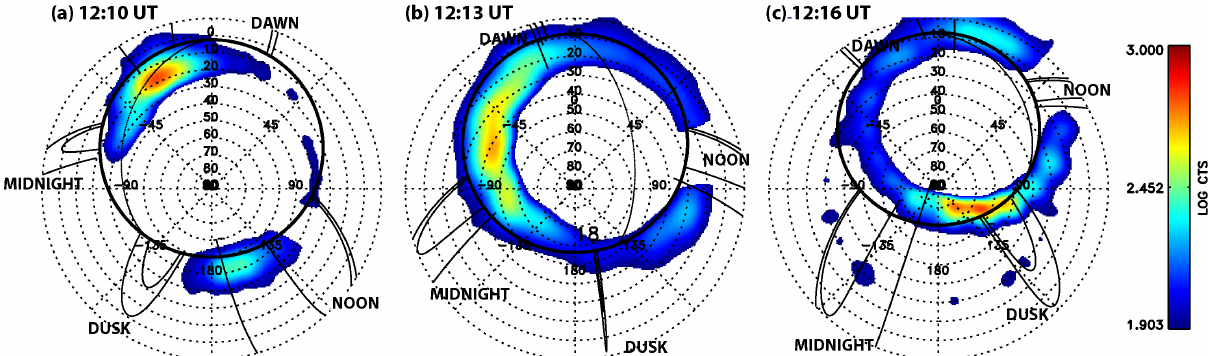
Fig. 13. A sequence of plots showing ENA emissions recorded by NUADU on 14 September 2004 while traversing the south polar cap. The SM co-ordinate system utilised has its Z-axis parallel to the dipole axis of the Earth; the XZ plane contains the Earth-Sun direction and the Y axis is perpendicular to the Earth-Sun line towards dusk. The image is displayed in an equidistant, azimuthal, projection. The solid circle represents the limb of the Earth and the terminator is depicted by a solid line. The dipole field lines of L-shells 4 and 8 are drawn at four local times for reference. The dotted background grid represents the instrumental co-ordinates of the NUADU instrument. The radial direction of the grid is the FWHM of the sector’s response, and the azimuthal direction is the spin direction.